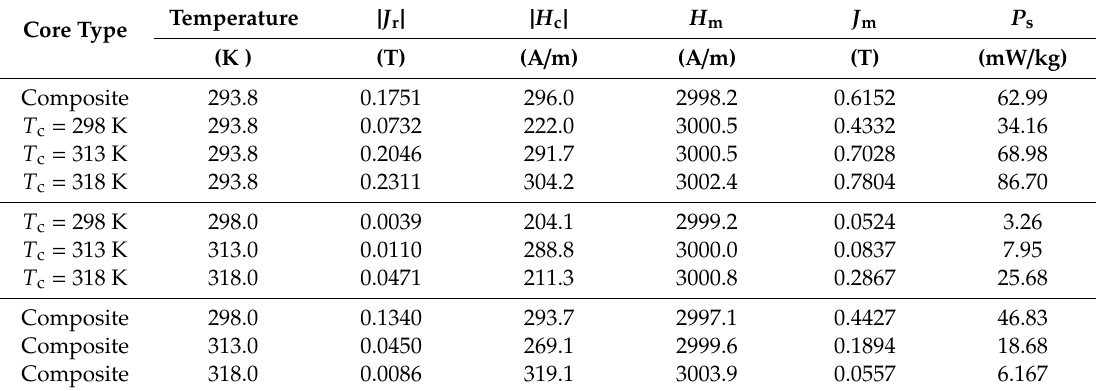
Table 3. Magnetic parameters of the tested samples at room temperature and Curie points.